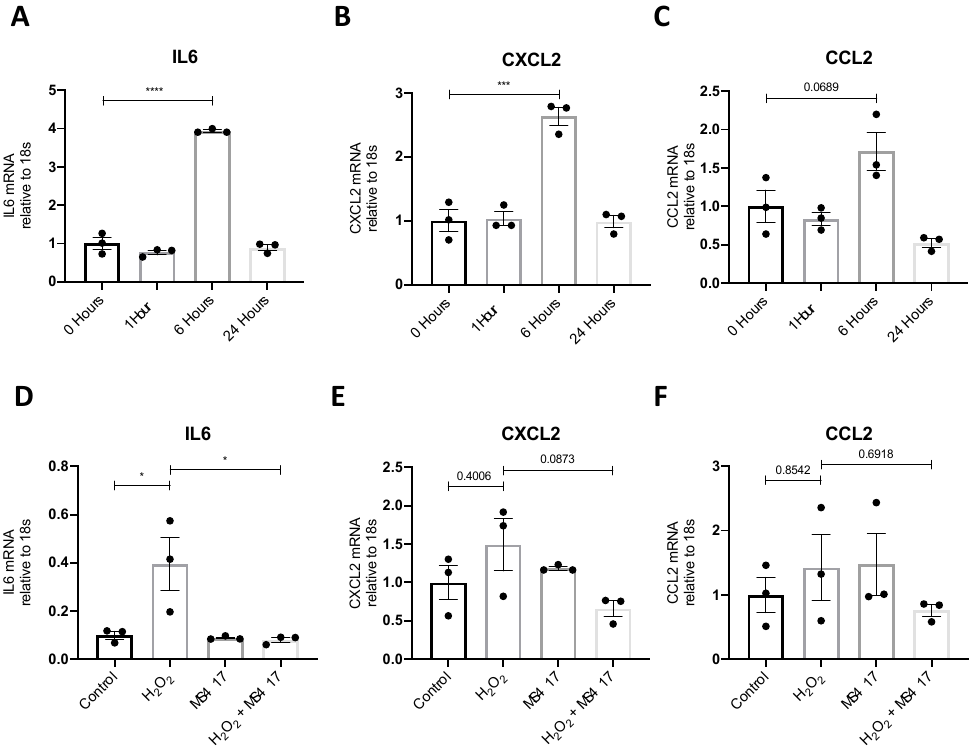
Figure 5. BRD4 attenuated the gene expression of NF κ B-mediated genes. ( A – C ) Exposure time was optimized by treating PTECs with H 2 O 2 for 0, 1, 6, and 24 h before cells were collected to qPCR analysis of IL6 ( A ), CXCL2 ( B ) and CCL2 ( C ). ( D – F ) In a subsequent set of studies, cells were treated with 1 µ M MS417 for 2 h followed by H 2 O 2 for 6 h followed by qPCR. n = 3, * p < 0.05, *** p < 0.001, **** p < 0.0001.